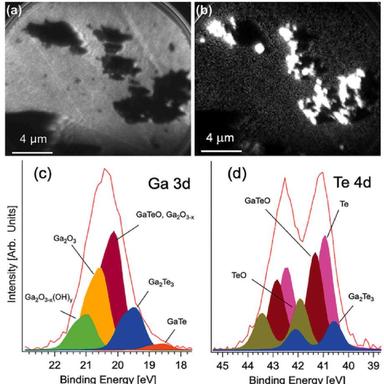
XPEEM images at the (a) Si 2p and (b) Te 4d core levels. XPS spectra in the region of (c) Ga 3d and (d) Te 4d core levels. Photon energy was 150 eV.